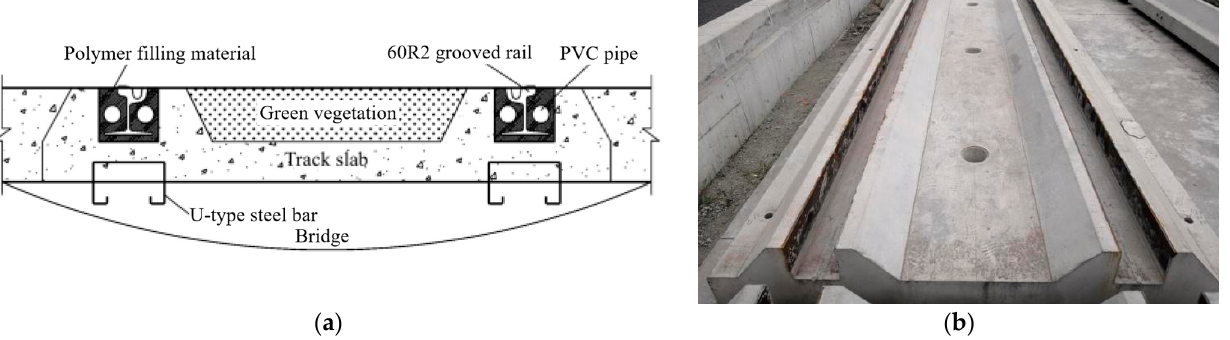
Figure 2. Tram-embedded track. ( a ) Track structure cross-section and ( b ) track physical map.